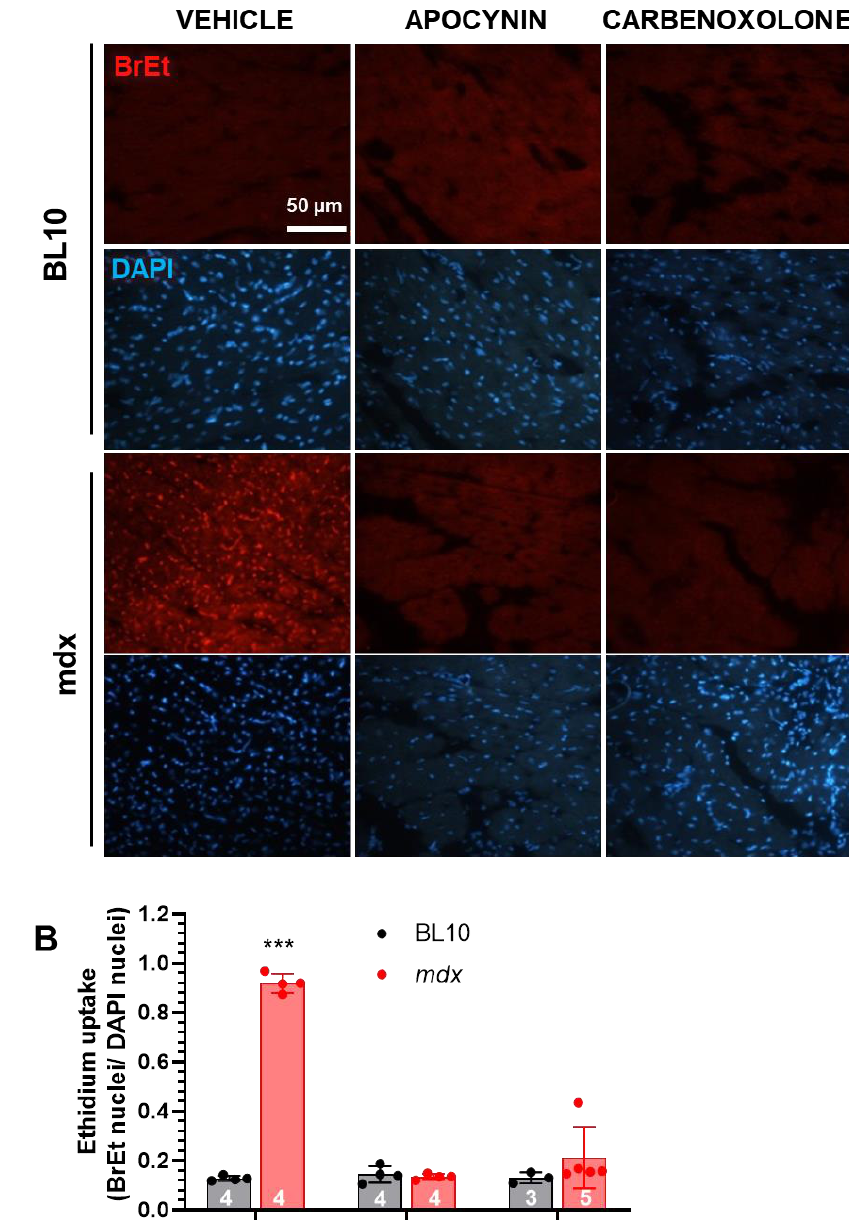
Figure 3. Increased permeability of Cx43 hemichannels in dystrophic hearts. Cardiomyocyte´s permeability was evaluated in Langendorff-perfused hearts using uptake of ethidium (BrEt) as a tracer. ( A ) Representative images of cardiac sections showing ethidium fluorescence (red, top set of panels) and nuclei stained by DAPI (blue, bottom set of panels). The first two columns show control (BL10) and mdx mice treated with the vehicle or apocynin for one month before the perfusion experiment; the third column shows hearts of both strains treated acutely with carbenoxolone (CBX, 10 µmol/L) during perfusion, prior to the ethidium challenge. ( B ) Ethidium uptake quantification, expressed as the ratio of ethidium-positive nuclei to total nuclei. The n is indicated in each bar. *** p < 0.001 vs. all the other groups, ANOVA with Newman–Keuls as post-hoc test.